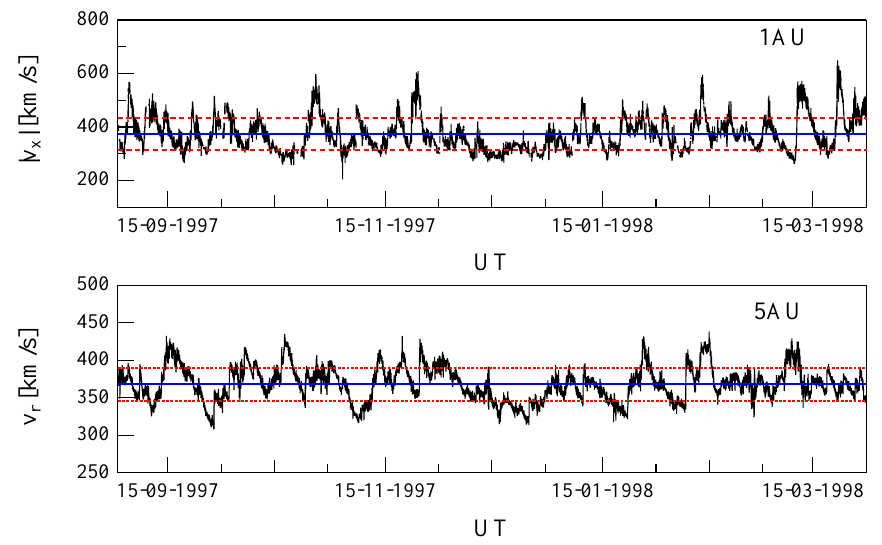
Fig. 1. The X-component of the solar wind velocity at 1AU (upper panel) and the radial component of the solar wind velocity at 5AU (lower panel) for the period from 1 September 1997 to 31 March 1998. Horizontal solid blue lines indicate mean values (blue line); dashed lines limit ± 1 standard deviation